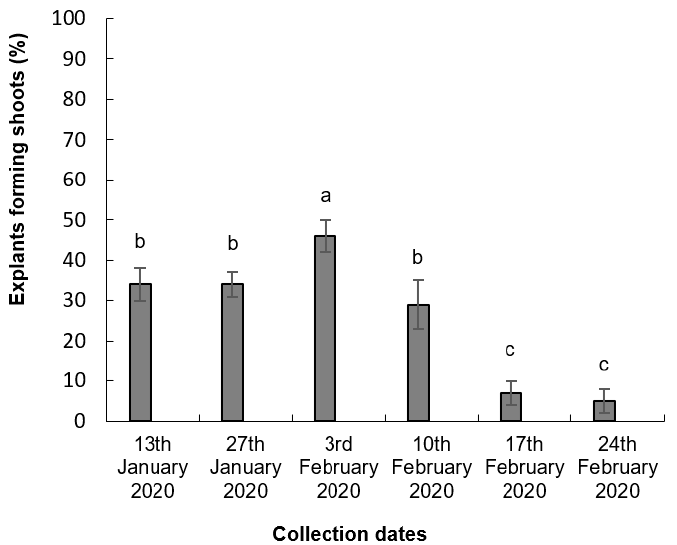
Figure 2. Explants forming shoots (%) shown in buds of Pinus radiata D. Don adult trees collected on different dates and cultured in Quoirin and Lepoivre (LP) medium [27], modified according to Aitken-Christie et al. [28]. Data are presented as mean values ± S.E. Different letters indicate significant differences by Tukey’s post hoc test ( p < 0.05).